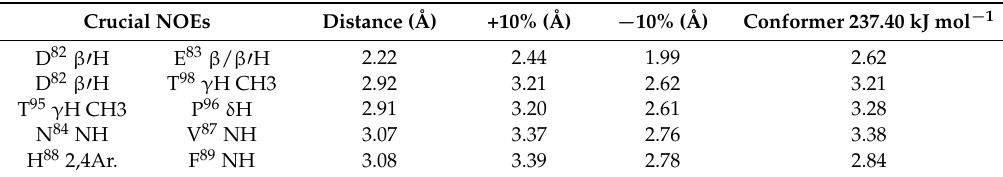
Table 2. Nuclear Overhauser Effects (NOE) distance constrains and corresponding distances for each class of conformers for cyclic MBP 82 – 98 (A 91 ).